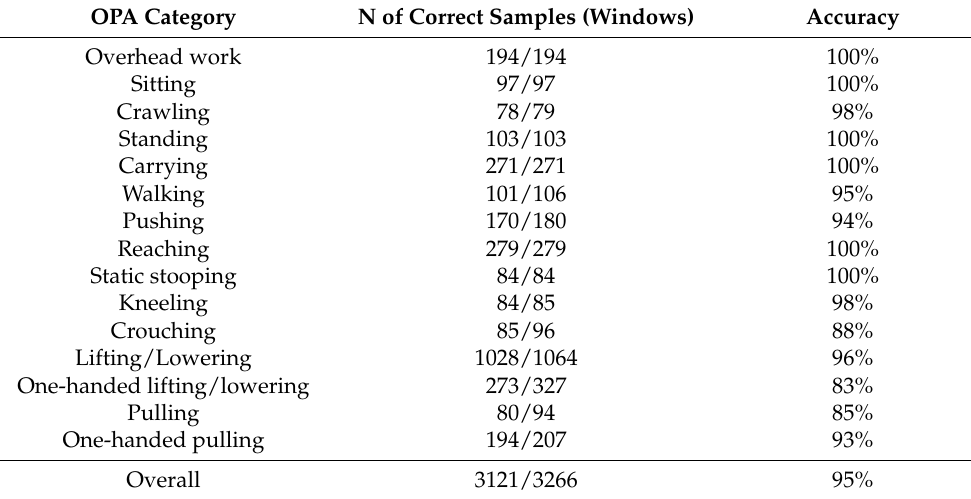
Table 4. CNN model accuracy of different OPA categories ( N = number of correct predictions over total samples for each OPA. Accuracy is the percentile of correct predictions divided by total